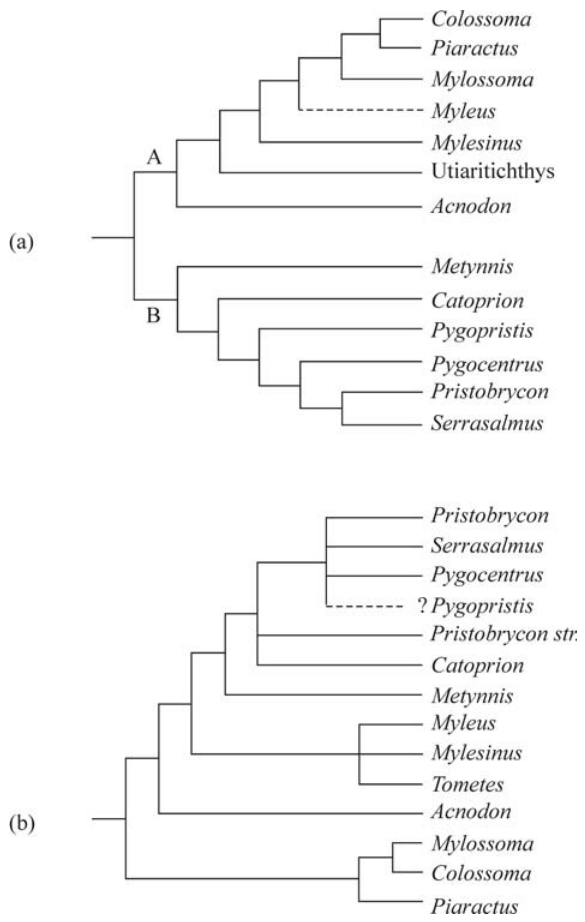
Figure 1 - Previous phylogenetic hypotheses for the Serrasalmidae: (a) phylogenetic relationships within the subfamily Serrasalminae proposed by Machado-Allison (1983) based on morphological characters and (b) Ortí et al. (1996) based on partial mtDNA sequences of the 12S and 16S ribosomal RNA